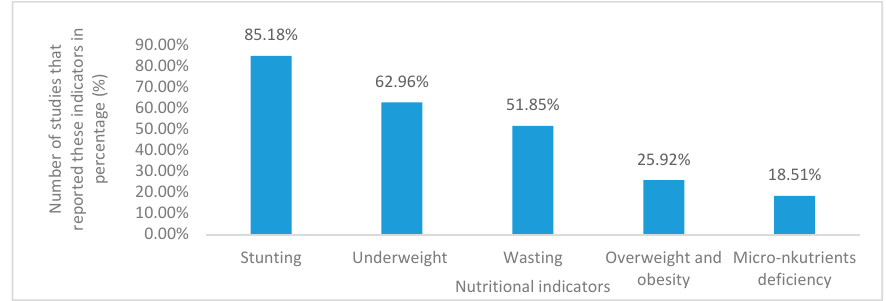
Figure 5. Nutritional status indicators of children in South Africa from selected studies.